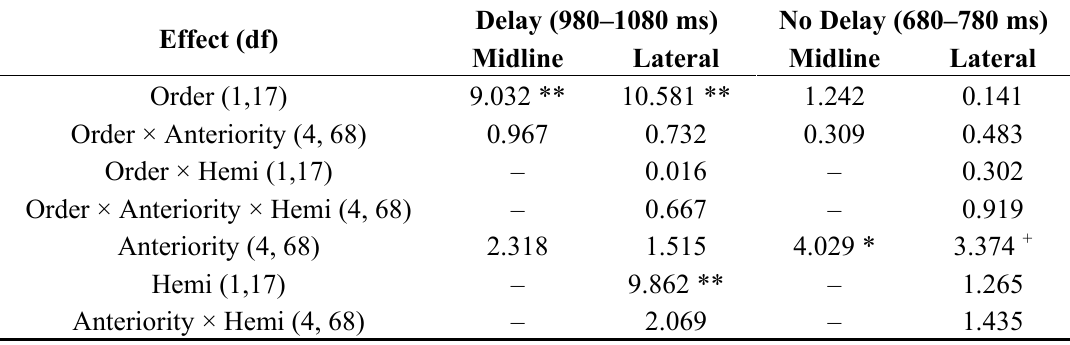
Table 8. Results for follow-up ANOVA ( F -values), 180–280 ms from the post-delay letter, separately for delay and no-delay